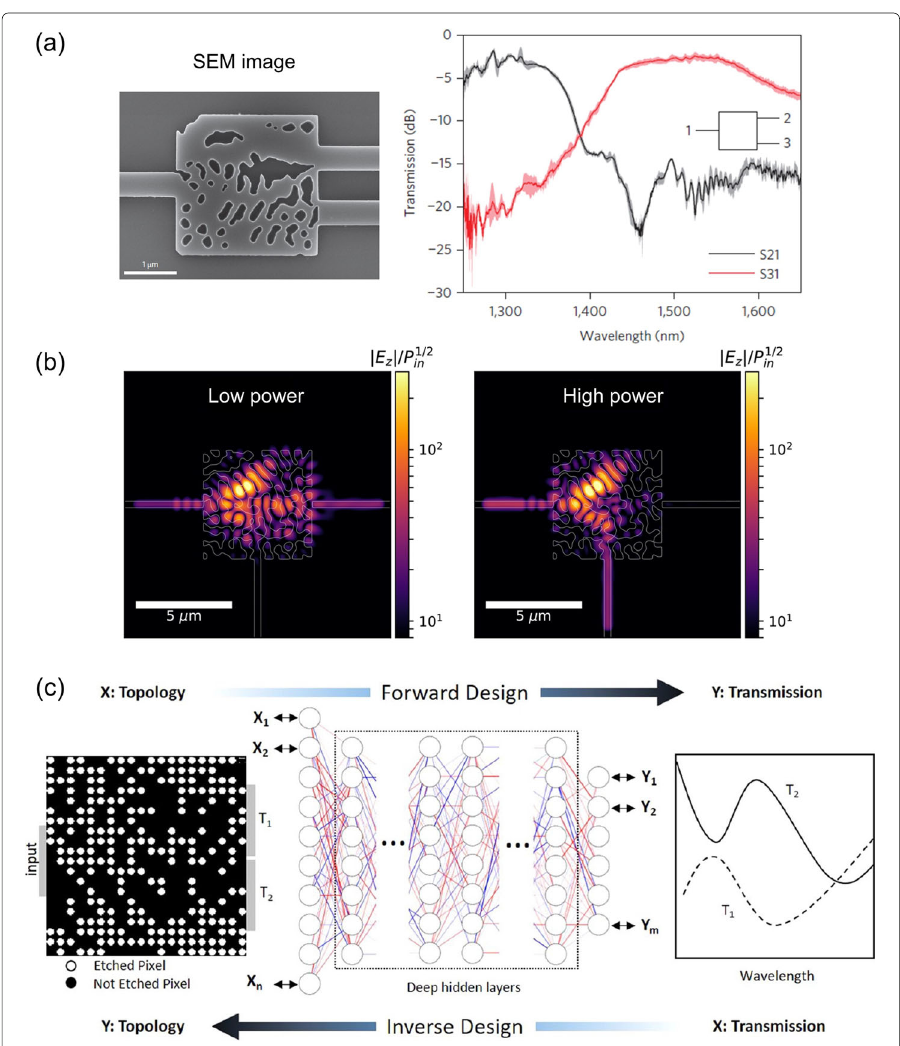
Fig. 9 (a) A TO-modified 1 × 2 beam splitter. Left: an SEM image (size: 2.8 × 2.8 μ m 2 ). Right: the measured transmissions. The S-parameters exhibit low insertion losses down to -1.8 dB and -2.4 dB in the 1300 nm and 1550 nm bands, respectively, and the crosstalk is suppressed < -11 dB throughout both bands. (b) An adjoint method-derived beam switch displaying different E-field distributions induced by the Kerr nonlinearity. Left: the light passes to the right port in case of a low power of 10 − 9 W/ μ m. Right: the light goes to the downward gate with a high input power of 0.057 W/ μ m. (c) A DNN-based framework for fast prototyping of 1 × 2 power splitters. Left: the spatial configuration of a close-packed splitter (footprint: 2.6 × 2.6 μ m 2 ). The exported intensity division is given by T 1 : T 2 , and effective manipulations of arbitrary ratios count on manipulating binary positional sequence of 20 × 20 etch holes (white circles). Middle: the established DNN model for forward and inverse modeling of nanophotonic devices. Right: targeted transmision spectra of the beam splitter. Figures reproduced with permission: (a) Ref. [26], Copyright 2015 Nature Publishing Group; (b)